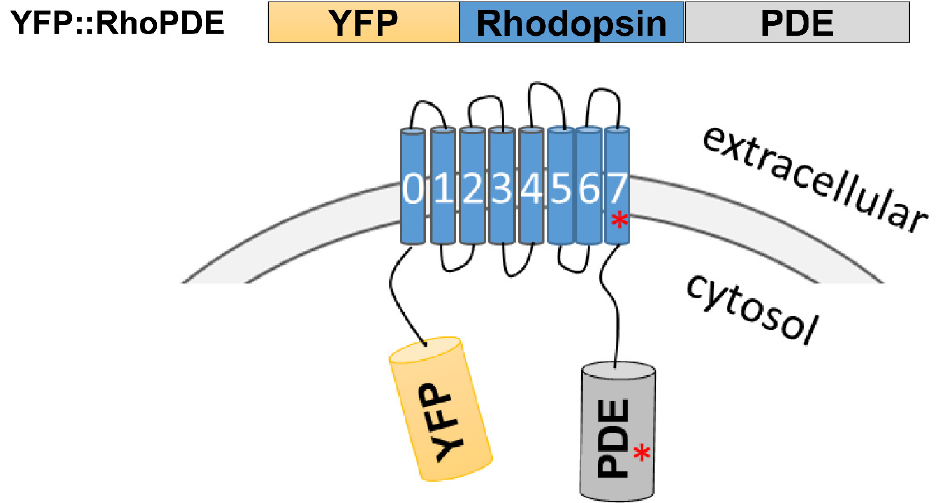
Figure 1. Schematic model of YFP::RhoPDE. The rhodopsin and phosphodiesterase domains were annotated by the PFAM database. Cf RhoPDE2, 3 and Cp RhoPDE1, 2 were predicted with very short N-terminal sequences. The red asterisks represent some key mutations in the last transmembrane helix or PDE catalytic domain of As RhoPDE, Cf RhoPDE2, Cf RhoPDE3 and Cp RhoPDE1.